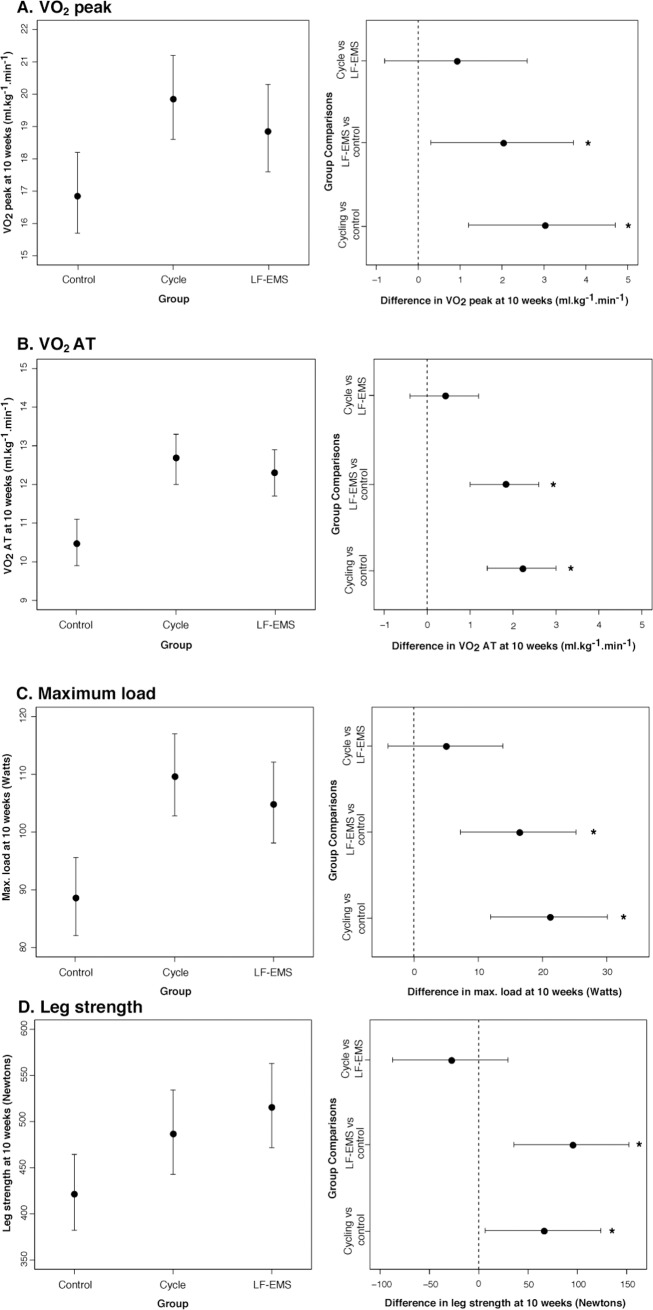
Least squares means at 10 weeks adjusted for baseline value, age and sex (left panels), and difference between groups in least squares means at 10 weeks (right panels) for (A) peak oxygen uptake (VO2 peak); (B) oxygen uptake at anaerobic threshold (VO2 AT); (C) maximum load (max. load); and (D) leg strength. Right hand panels show the superiority of cycling and LF-EMS over control for all variables (A-E) and no difference between cycling and LF-EMS. LF-EMS, low-frequency electrical muscle stimulation; *P<0.05.